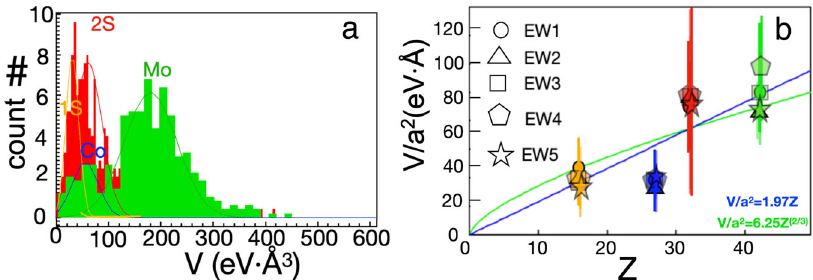
Fig. 2 Stoichiometric interpretation of the Co-Mo-S exit wave. a Histograms of V values obtained from the metal and sulfur sub-lattice, marked by green and red, respectively, in the V map (Fig. 1f). The histogram peaks are assigned to 1Mo, 1Co, 2S and 1S, respectively. The histogram peaks are fi tted by Gaussian functions (superimposed) having peak positions and standard deviations as listed in Supplementary Table 1. b The projected potential ( V ) scaled by the atomic area ( a 2 ) is plotted versus the assigned projected atomic number of the column ( Z ). The V / a 2 values are obtained from the peak positions and standard deviations of the Gaussian fi ts to the V histograms for each exit wave (Supplementary Table 1) and from a being 145, 135, and 110 pm for Mo, Co, and S, respectively. The data is best fi tted by V / a 2 = α 1 Z with α 1 = 1.97 ± 0.12 eV Å (blue line) and V / a 2 = α 2 Z 2/3 with α 2 = 6.25 ± 0.15 eV Å (green line), respectively. Moreover, the Z 2/3 -dependency corresponds to the potential V = α 3 Z 2/3 with α 3 = a 2 α 2 = 13.13 ± 0.32 eV Å 3 , obtained using a = 145